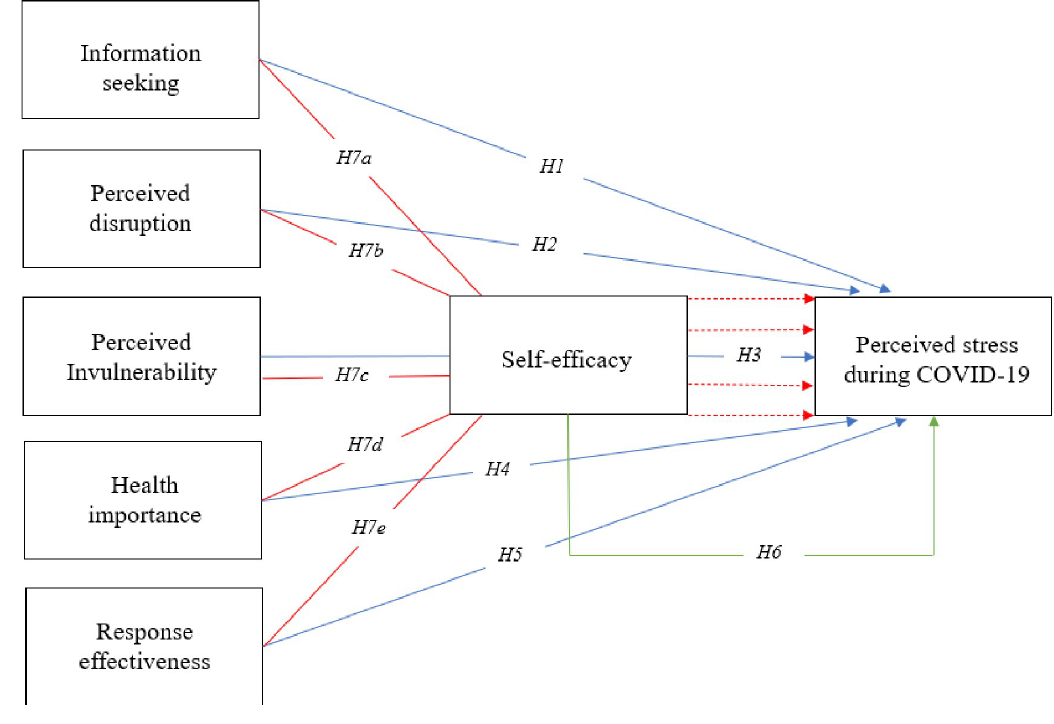
Fig 1. Theoretical